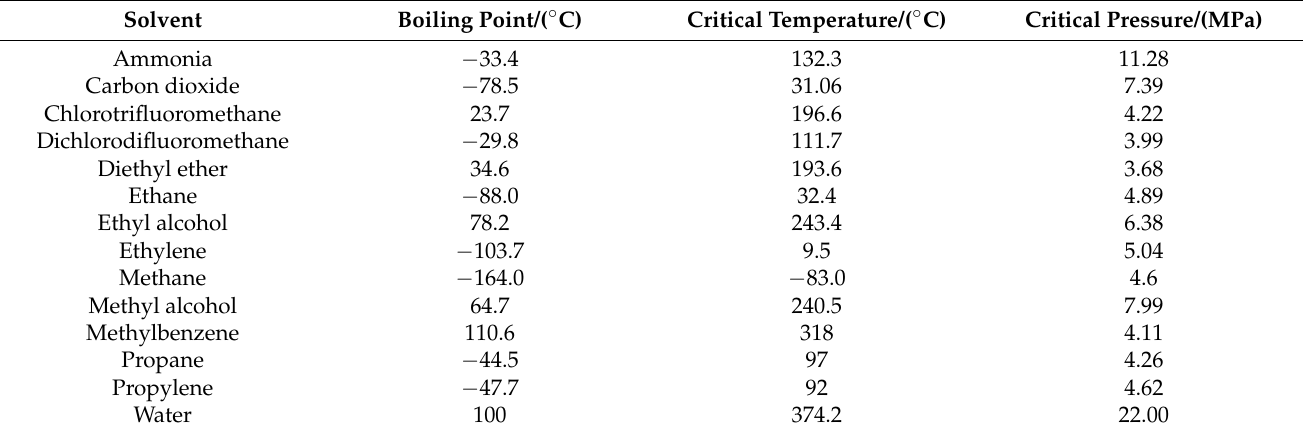
Table 5. Critical data of common